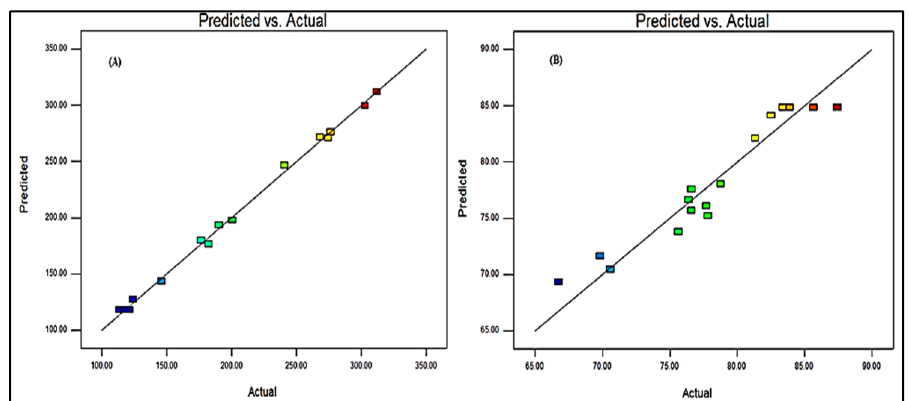
Figure 4. Actual and predicted value of particle size ( A ) and entrapment efficiency ( B ).